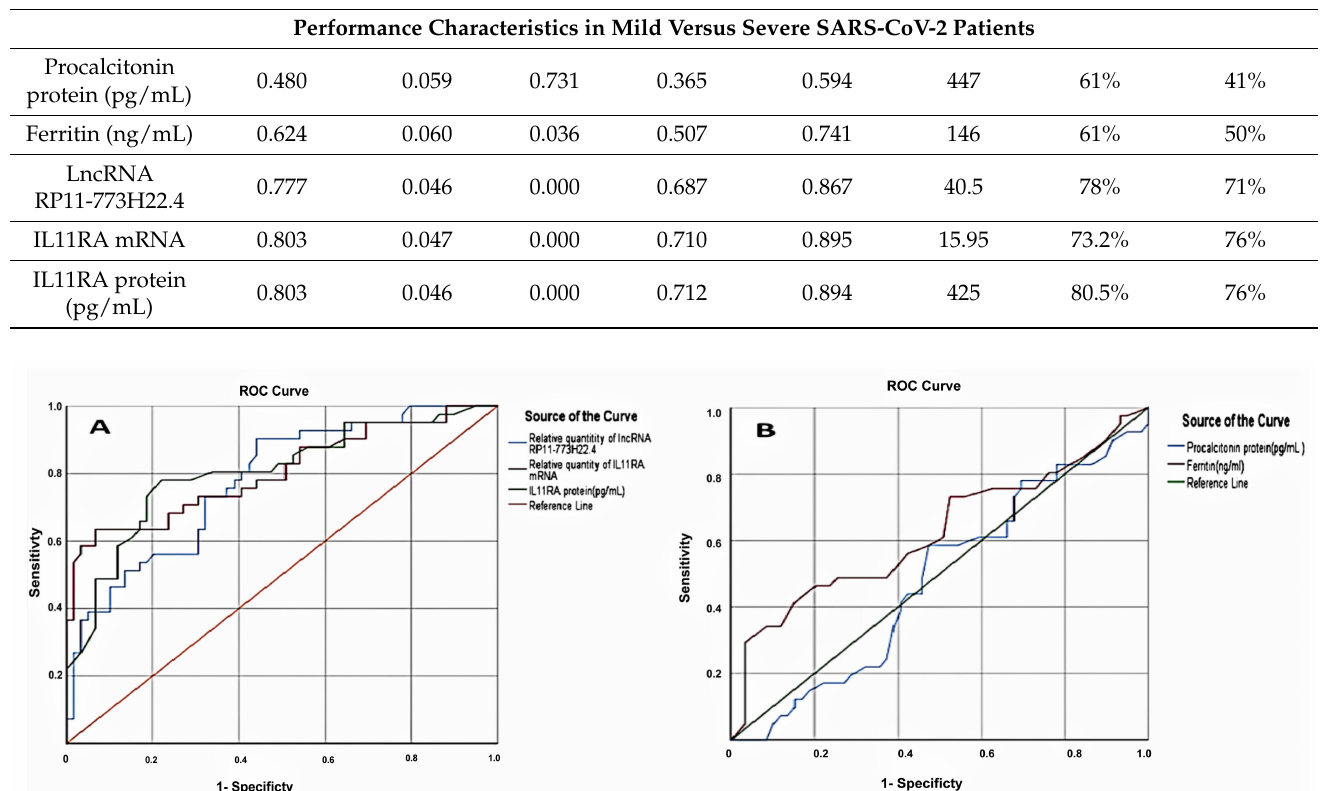
Figure 3. The receiver operator characteristic (ROC) curve presents the diagnostic accuracy of the IL11RA mRNA panel discriminating between mild and severe cases of SARS-CoV-2: ( A ) IL11RA mRNA and protein, and LncRNA RP11-773H22.4. ( B ) Procalcitonin and